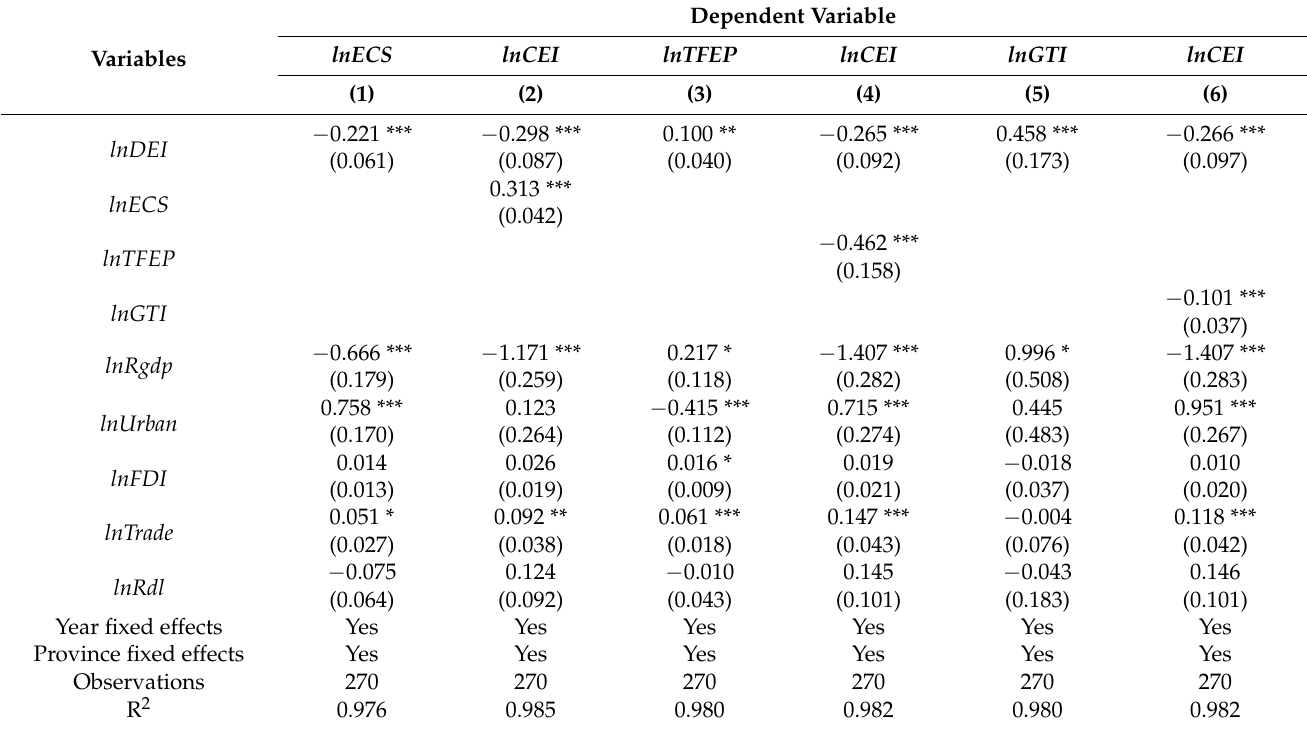
Table 8. Mechanism test of the effect of digital economy on carbon emission